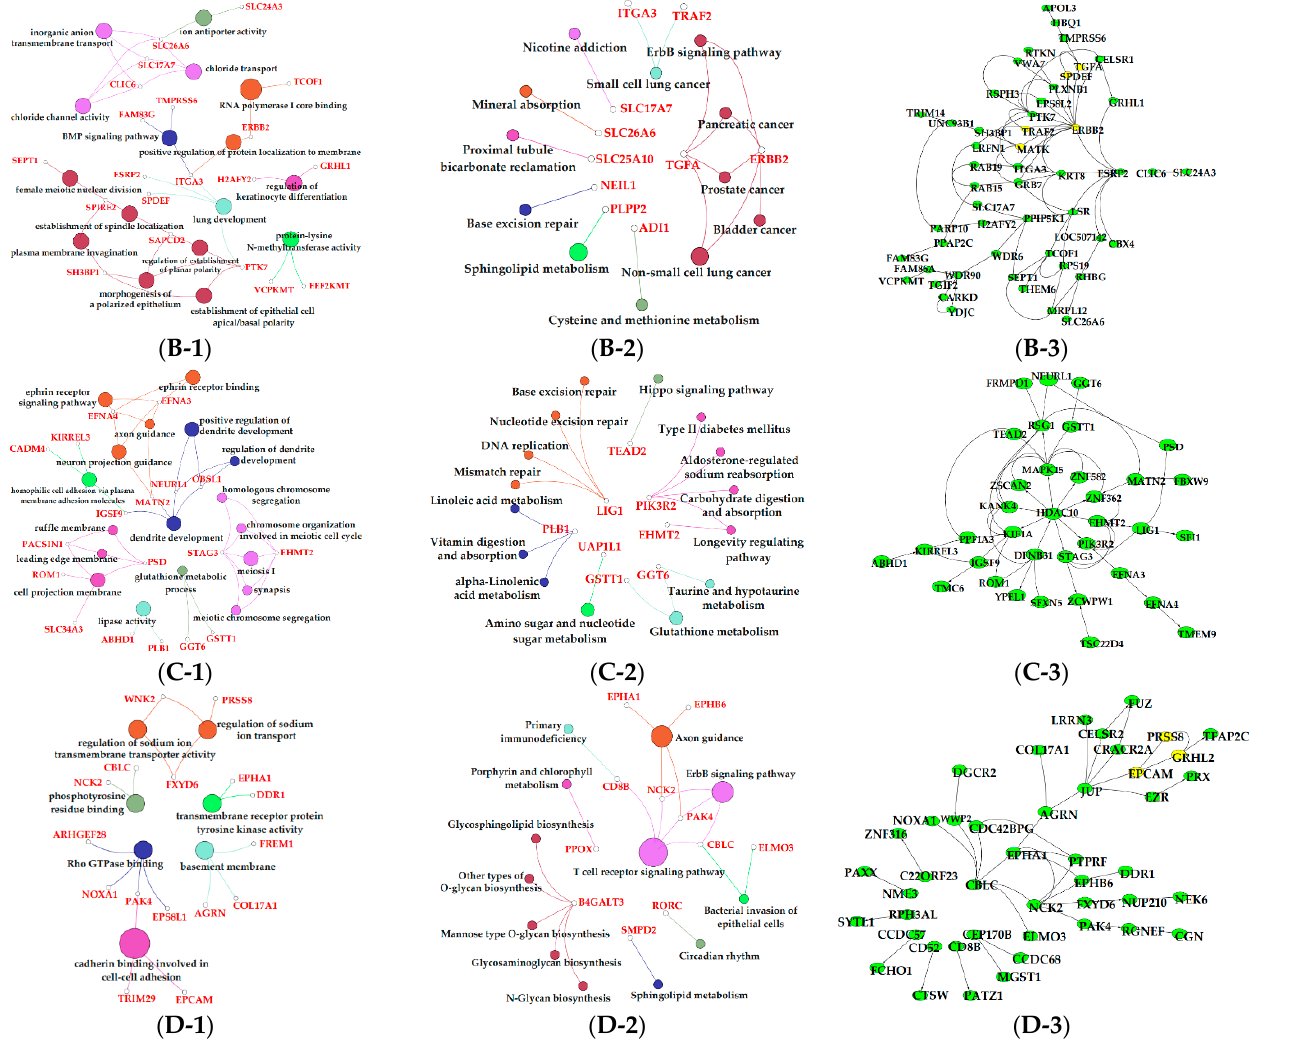
Figure 8. Functional analysis of genes in black, red, pink and yellow modules. Gene ontology (GO) analysis of genes in black ( A-1 ), red ( B-1 ), pink ( C-1 ) and yellow ( D-1 ) modules. Kyoto Encyclopedia of Genes and Genomes (KEGG) pathway analysis of genes in black ( A-2 ), red ( B-2 ), pink ( C-2 ) and yellow ( D-2 ) modules. The significant GO terms and KEGG pathways were visualized using Cytoscape software based on network analysis of ClueGO/CluePedia inferred from MCODE clusters. The size of nodes indicated the p -value. The color of nodes represented the functional group that they belonged to. The names of important pathways were in black bold characters. The protein–protein interaction (PPI) networks showed the interactions of genes in black ( A-3 ), red ( B-3 ), pink ( C-3 ) and yellow ( D-3 ) modules, respectively. Each node represented a gene and the yellow nodes expressed the key genes in each module.